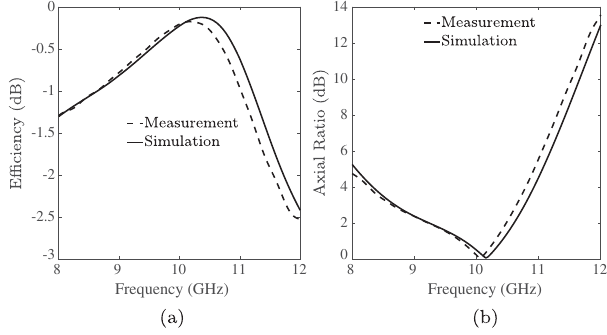
FIG. 11. Measurement results of (a) efficiency and (b) axial ratio of the fabricated QWP.